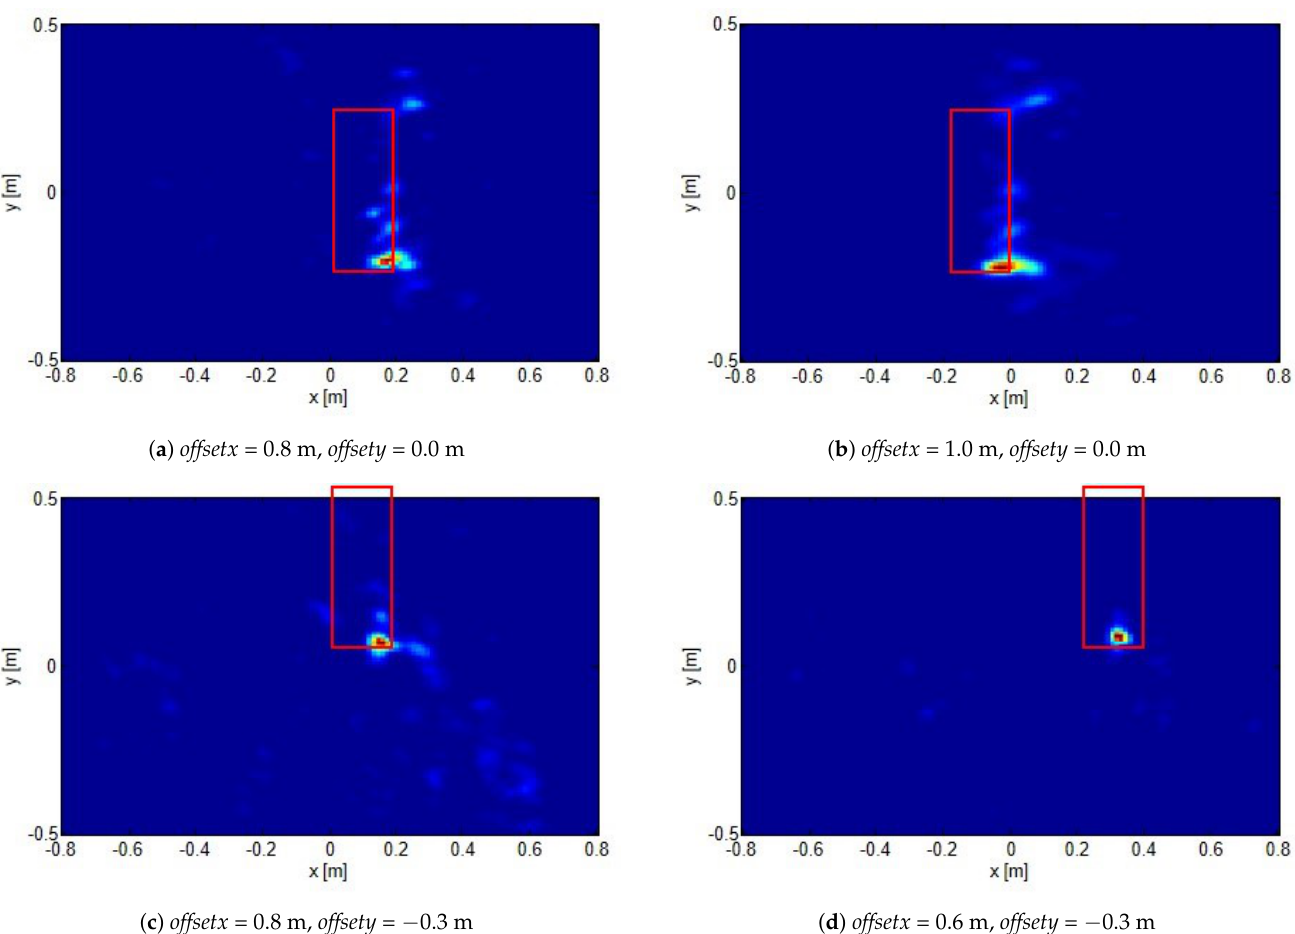
Figure 4. Normalized reconstructions for target located at position 1 shown in Figure 3b for different investigation domain offsets (reported in the figures). The red rectangles show the actual target